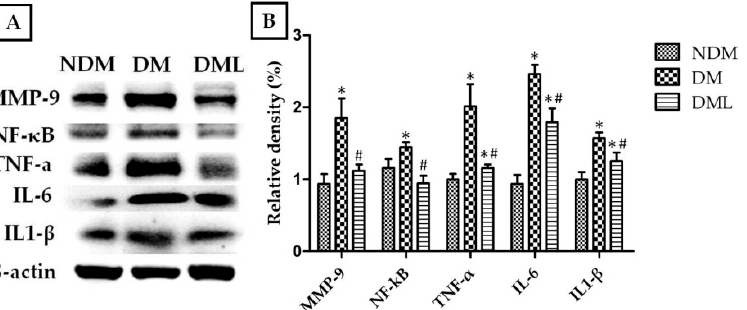
Figure 4. Effects of luteolin on protein expression levels of inflammatory factors of skin wound on day 14. ( A ) Tissues were homogenized in RIPA buffer and subjected to immunoblotting with anti-MMP-9, anti-NF- κ B, anti-TNF- α , anti-IL-6, and anti-IL1- β antibodies. ( B ) Quantitative results of MMP-9, NF- κ B, TNF- α , IL-6, and IL1- β protein levels were adjusted to β -actin protein level. Values of individual groups are presented as mean ± SEM. * p < 0.05, compared with the NDM group. # p < 0.05, compared with the DM group.